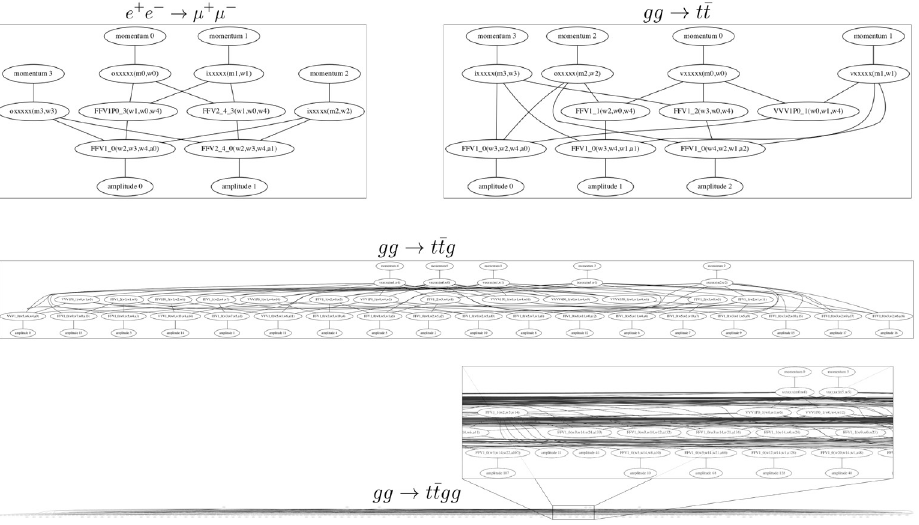
Figure 3. Visualization of the complexity of ME calculations for various physics processes. The detailed computation algorithm is described in Sec. 2. The only inputs to the calculation which vary from one event to another are the 4-momenta of the initial and final state particles in the collision (4 for µ + µ − and gg e + e − t ¯ t , 5 for gg t ¯ t g and 6 for gg t ¯ t gg → → → →